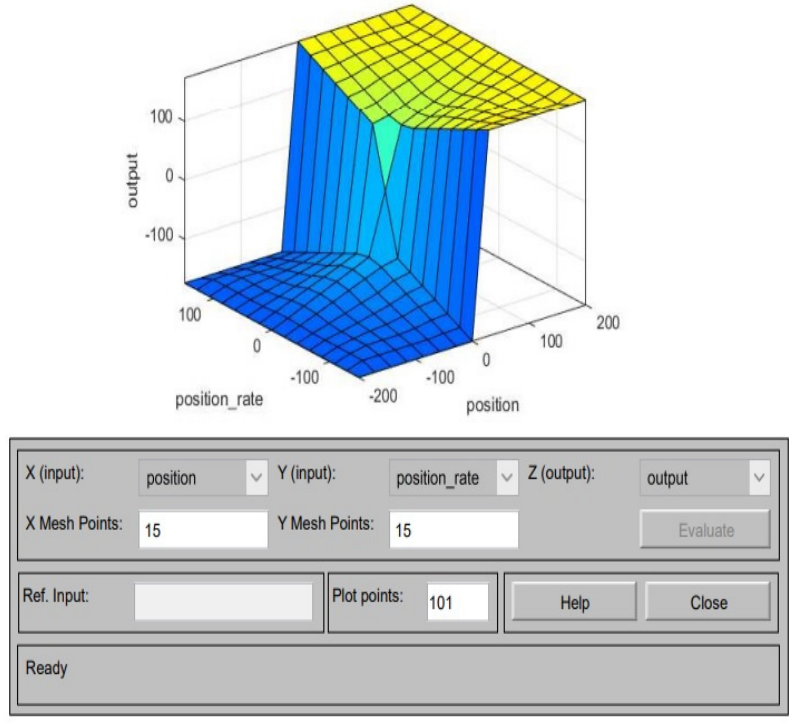
Figure 10. The surface viewer of the fuzzy. Table 2. The suggested controller design’s fuzzy rule base.